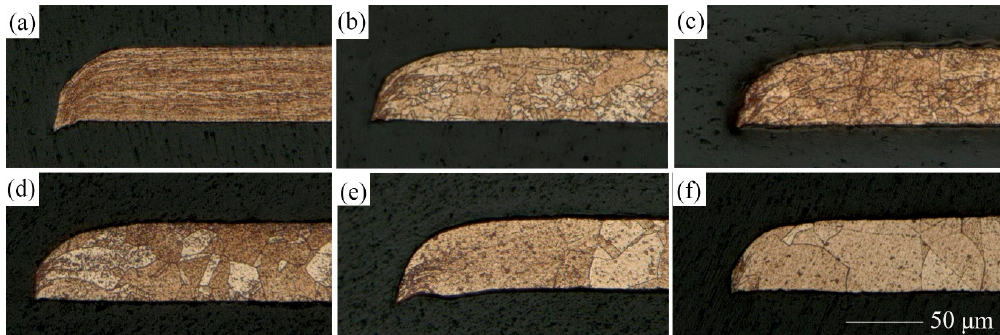
Figure 23. Microstructures of the punched parts without LPS under a laser energy density of 38.2 J/cm 2 . ( a ) Cold-rolled; ( b ) 350 °C annealed, 1 h; ( c ) 450 °C annealed, 1 h; ( d ) 550 °C annealed, 1 h; ( e ) 650 °C annealed, 1 h; ( d ) 650 °C annealed, 1 h.